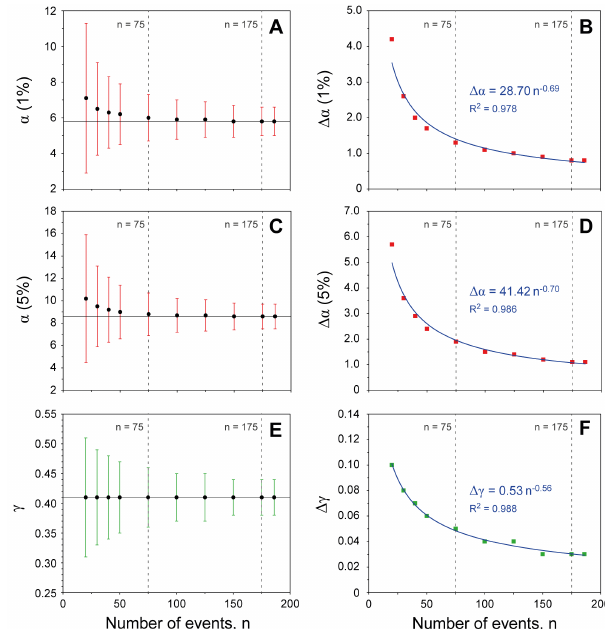
Fig. 5. Variation of the threshold model parameters ( α and γ) and of their uncertainties ( 1α and 1γ) as a function of the number of events n , for the 1% and the 5% exceedance probability levels. In the left plots, black dots show the average values of α (A, C) and γ (E) , and the coloured bars show the relative variations. In the right plots, coloured squares represent the values of 1α (B, D) and 1γ (F) , and the blue lines are best fits (linear regression method) to the empirical